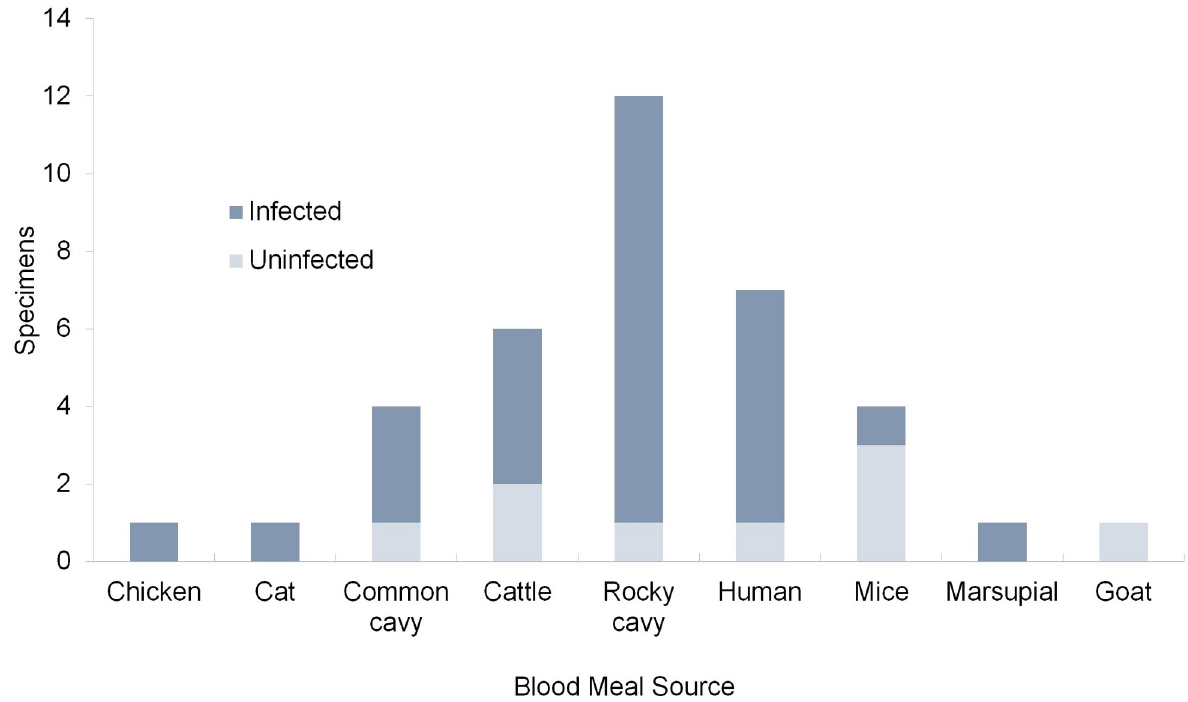
Fig 4. Blood meals sources of Triatoma b . brasiliensis identified in uninfected and infected specimens by T . cruzi from the Pedregulho, Ina´cio, S ã o Bernardo de Elias, Riacho do Santo, and the Batalh ã o de Engenharia de Construc¸ ã o localities in the Caico´ municipality, Rio Grande do Norte,